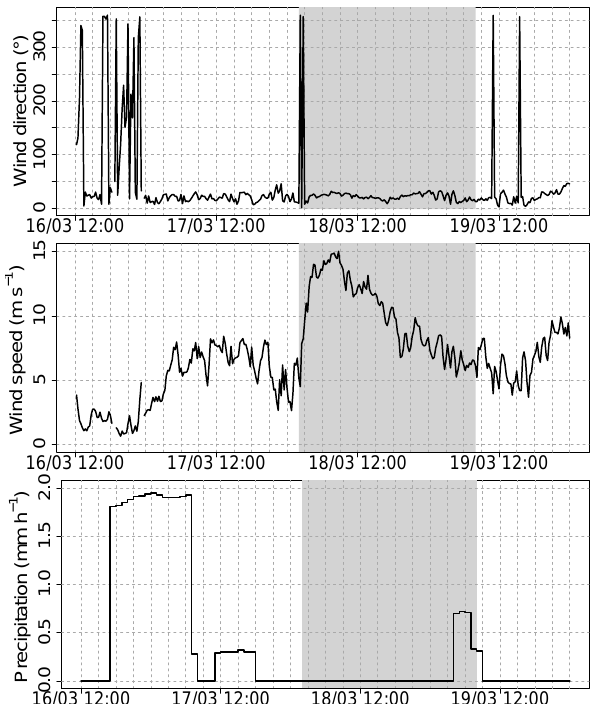
Fig. 4. Times series of observed wind direction (top) and speed (middle) and precipitation (bottom) at Col du Lac Blanc during 3.5 days around our case study (shown in gray). Precipitation are provided by the SAFRAN meteorological analysis system (Durand et al., 1993).